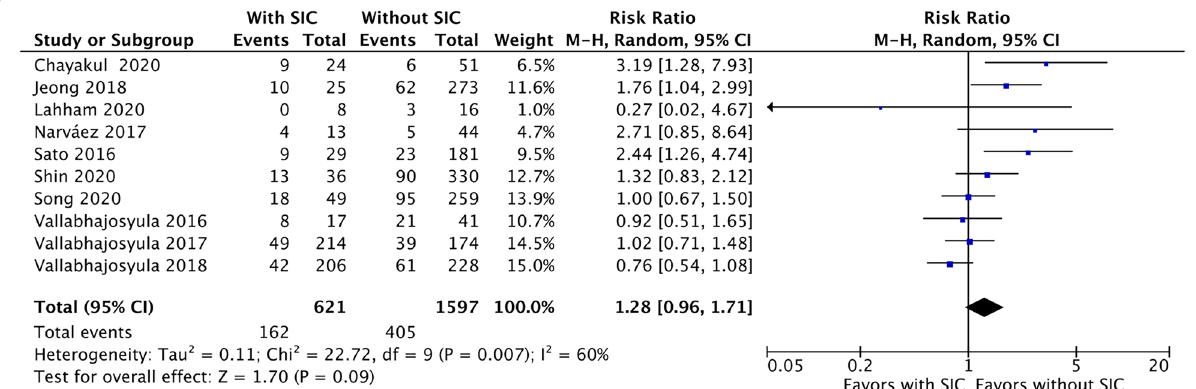
Fig. 2 The forest plot shows in‑hospital mortality between septic patients with and without sepsis‑induced cardiomyopathy (SIC). SIC is non‑statistically associated with higher risk of in‑hospital mortality among septic